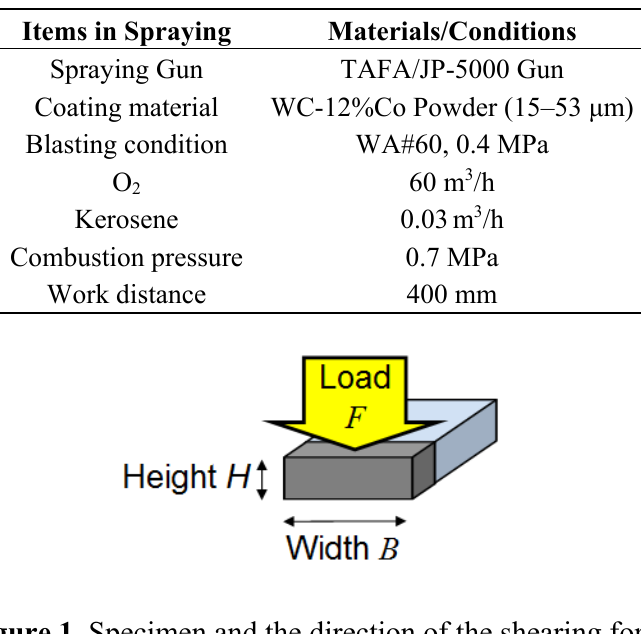
Figure 1. Specimen and the direction of the shearing